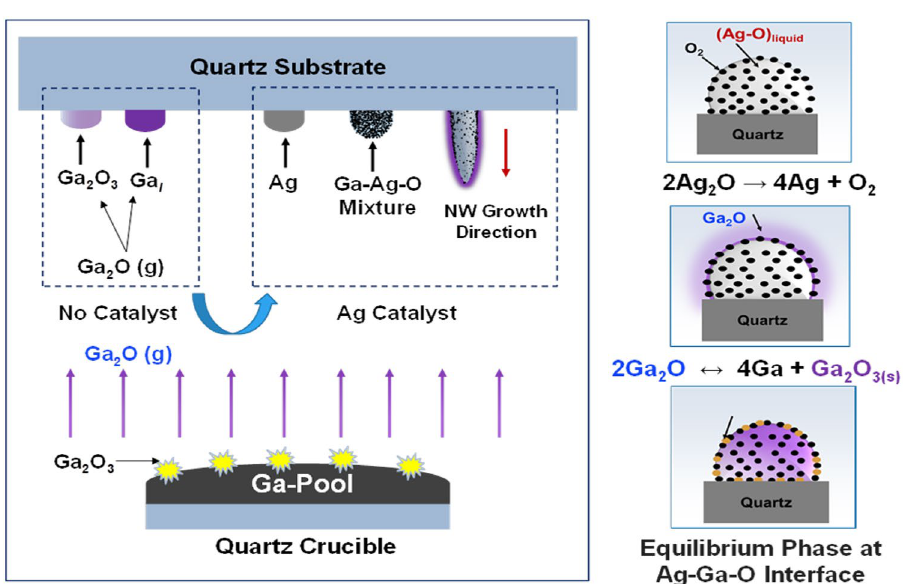
Figure 16. The growth mechanism of Ga 2 O 3 NWs on a quartz substrate coated with 5 nm Ag film (facing downward). A pool of liquid Ga is heated in a quartz crucible that sits under the quartz substrate with ~ 10 mm